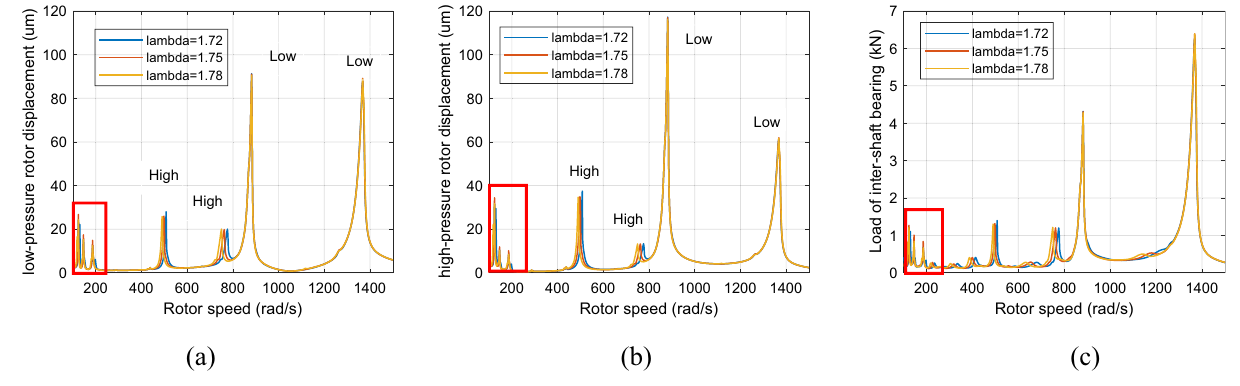
Figure 9. Amplitude-frequency response curve with defect (λ = 1. 72, 1. 75, 1. 78, F 0 = 100, A max = 200) ( a ) LP rotor ( b ) HP rotor ( c ) inter-shaft bearing’s load.